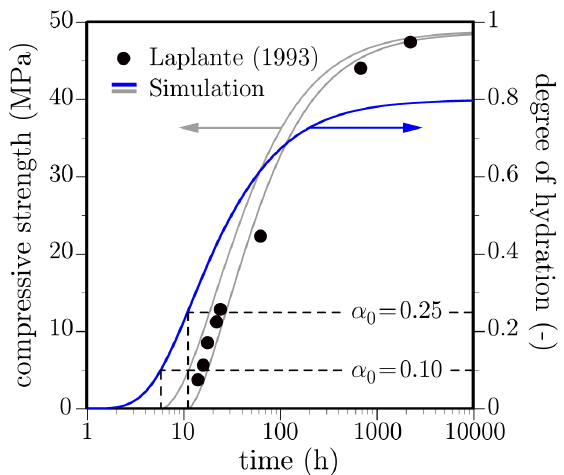
Figure 9. Strength development as a function of degree of hydration: dependence on setting parameter, α 0